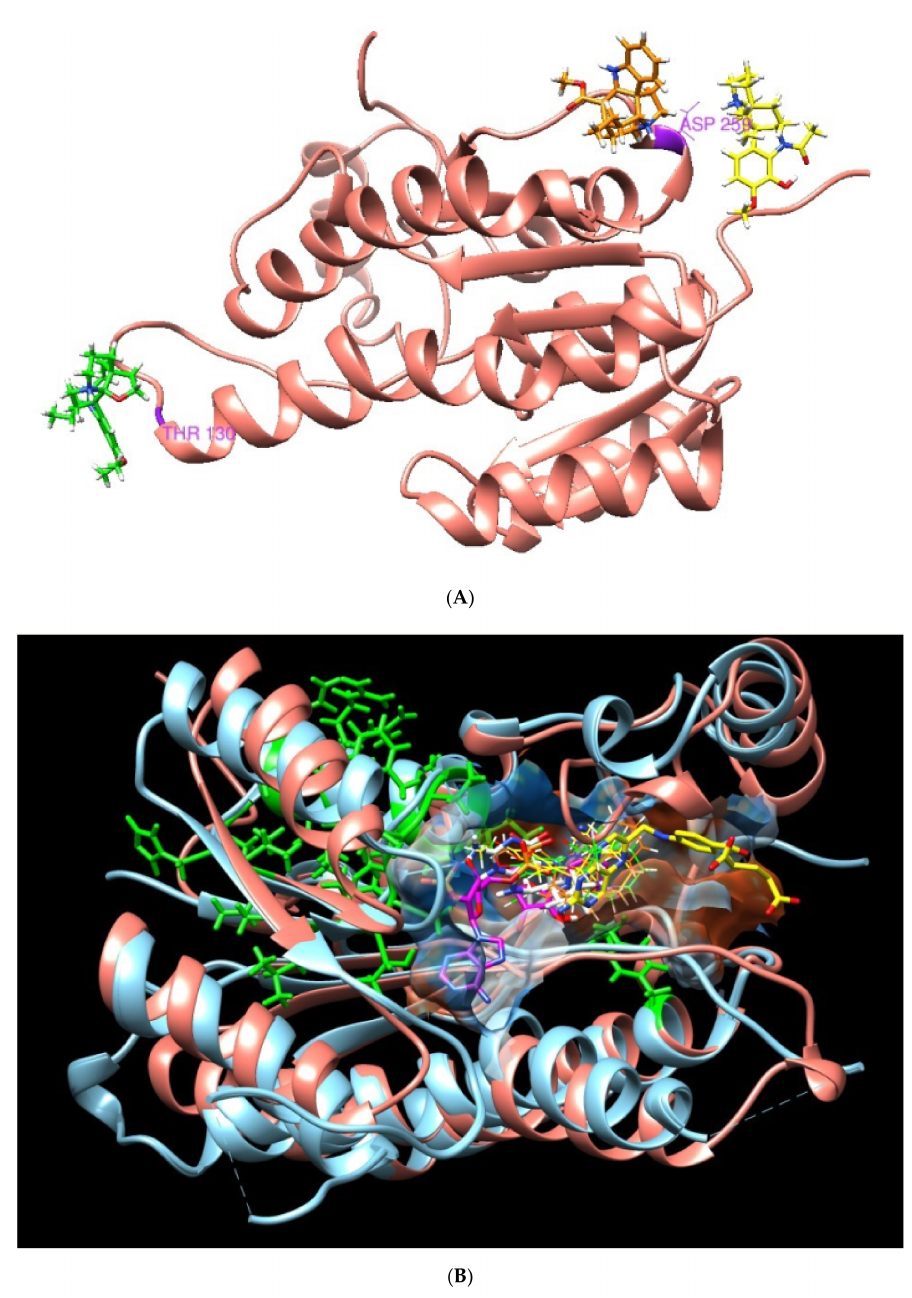
Figure 4. 3D molecular structure of human DHR and Leishmania PTR1. ( A ) Position of metabolites APC ( yellow ), APA ( green ) and TBT ( orange ) in DHR human target. ( B ) Superposition of active sites. Large green areas represent positions of physiological ligand binding